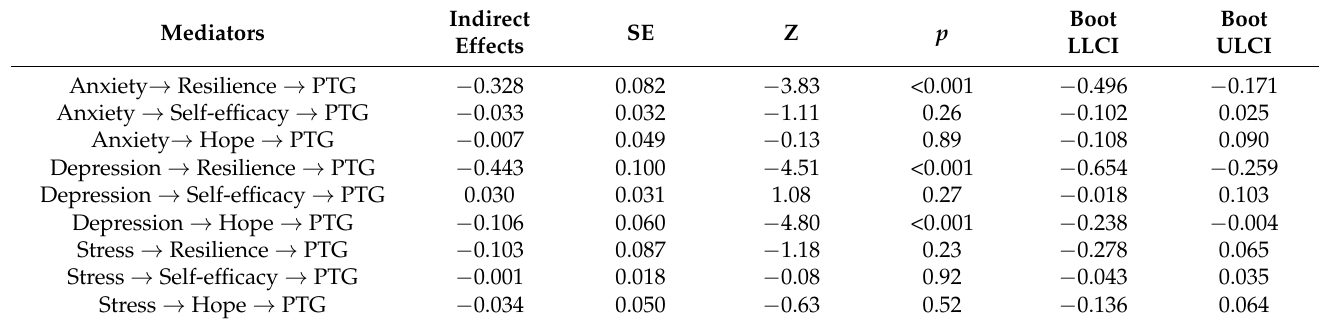
Table 4. Summary of indirect effects and confidence intervals of three mediators (N =